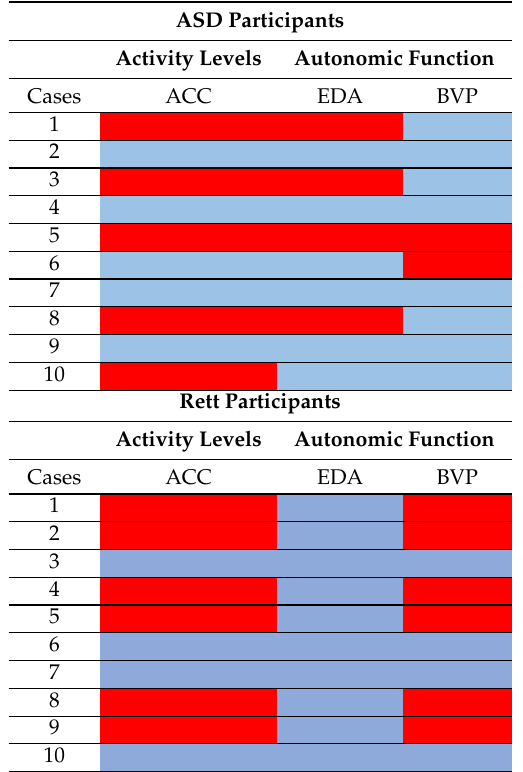
Table 2. Colour coded table showing the physiological profile for ASD and Rett syndrome participants (Blue colour indicates normal values and red colour indicates abnormal